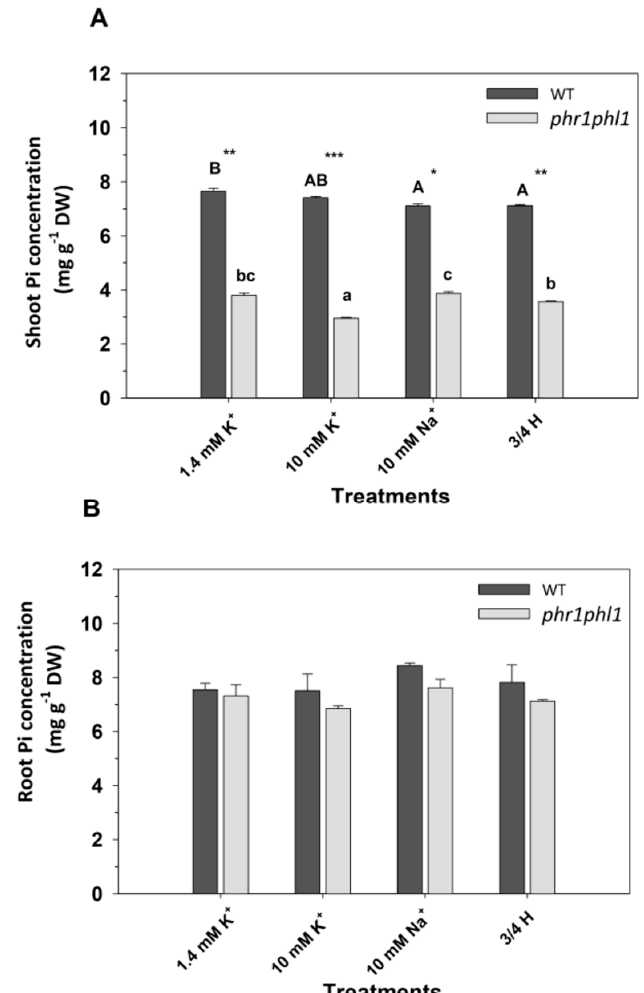
Figure 2. Shoot and root P concentrations of plants exposed to 1.4 mM KCl, 10 mM KCl, 10 mM NaCl, and a concentrated nutrient solution. Plants of WT (dark grey bars) and phr1phl1 mutant (light grey bars) were grown as described in Figure 1. Collected shoots and roots were dried, acid digested, and their Pi concentrations determined by Inductively Coupled Plasma (ICP) spectrometry analysis. Shown are average shoot ( A ) and root ( B ) Pi concentrations of three repetitions and errors bars denoted standard error. ANOVA was used to study the effects of the treatment (T), the genotype (G), and their interaction (TxG) resulting in: (A) T = ***, G = *** and TxG = ***. Bars with different letters within lines denote significant differences according to Tukey test (uppercase letters for WT and lowercase letters for phr1phl1 line). Differences between genotypes within the same treatment were analyzed according to ANOVA. ***, **, * indicate significant differences at p < 0.001, 0.01 and 0.05 respectively. (B) T = n.s, G = n.s. and TxG = n.s. n.s indicates non-significant at p > 0.05.